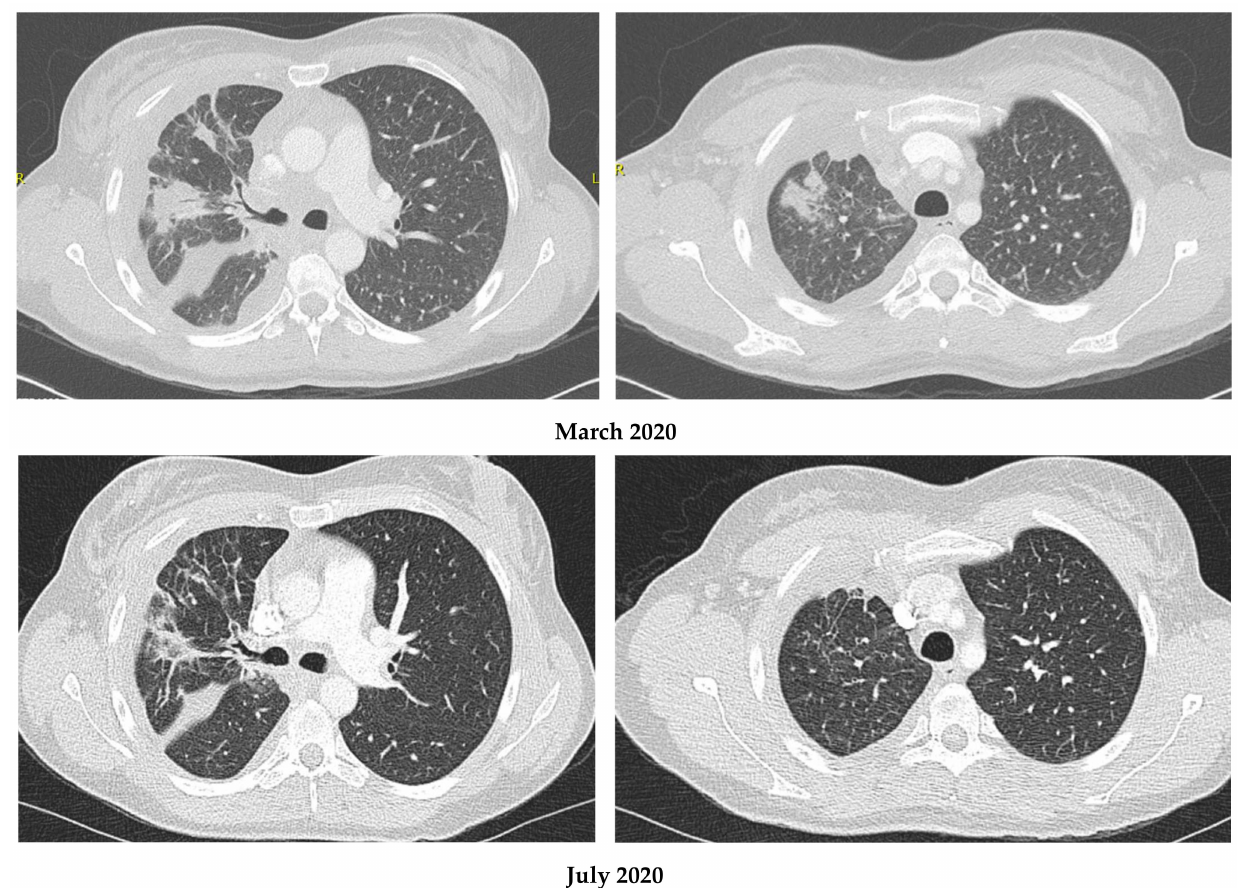
Figure 1. Disease response on Alectinib in patient 1. (Comparison between March and July 2020; 3 months of